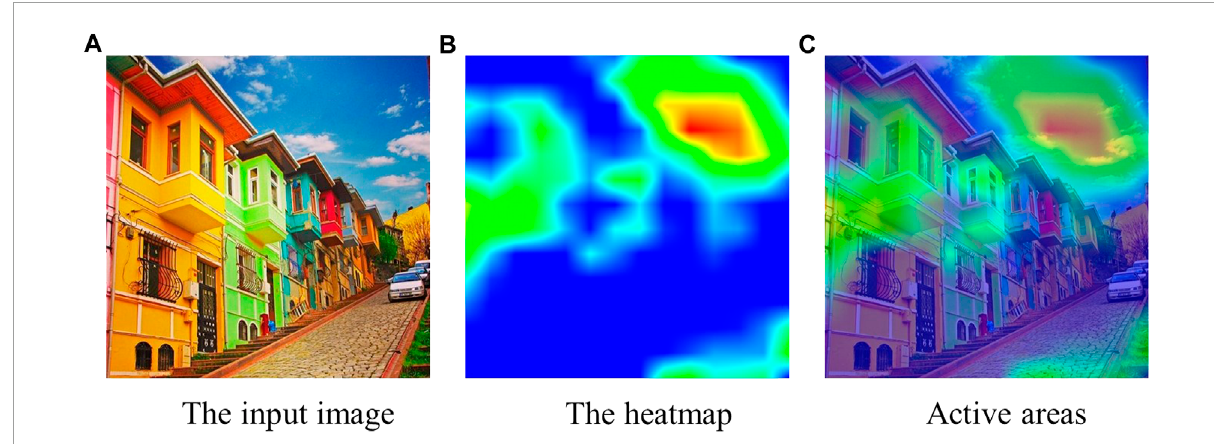
FIGURE 3 The input image (in (A) ), the heatmap from Grad-CAM (in (B) ), and the activations aligned with the original image (in (C) ) when the expression is “the blue sky.” The Grad-CAM heatmap highlights the sky using the color features, although the sky is not in the object categories of the MSCOCO